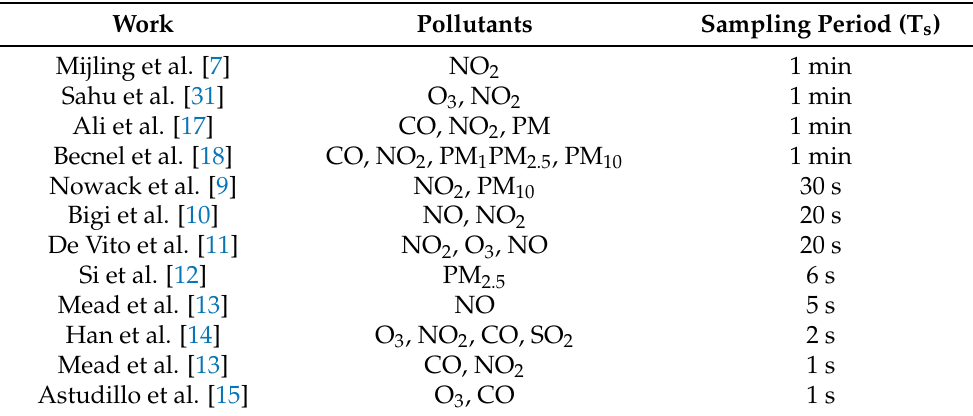
Table 1. Sensor sampling periods used in the